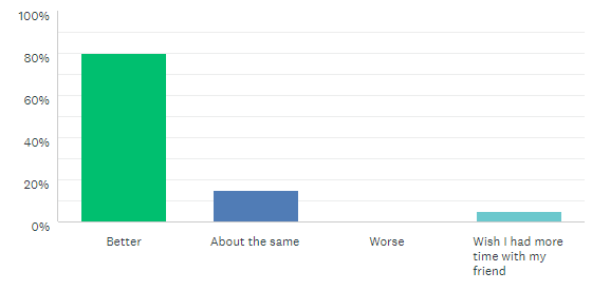
Figure 2. Respondents view on how they felt post-interaction with a friend